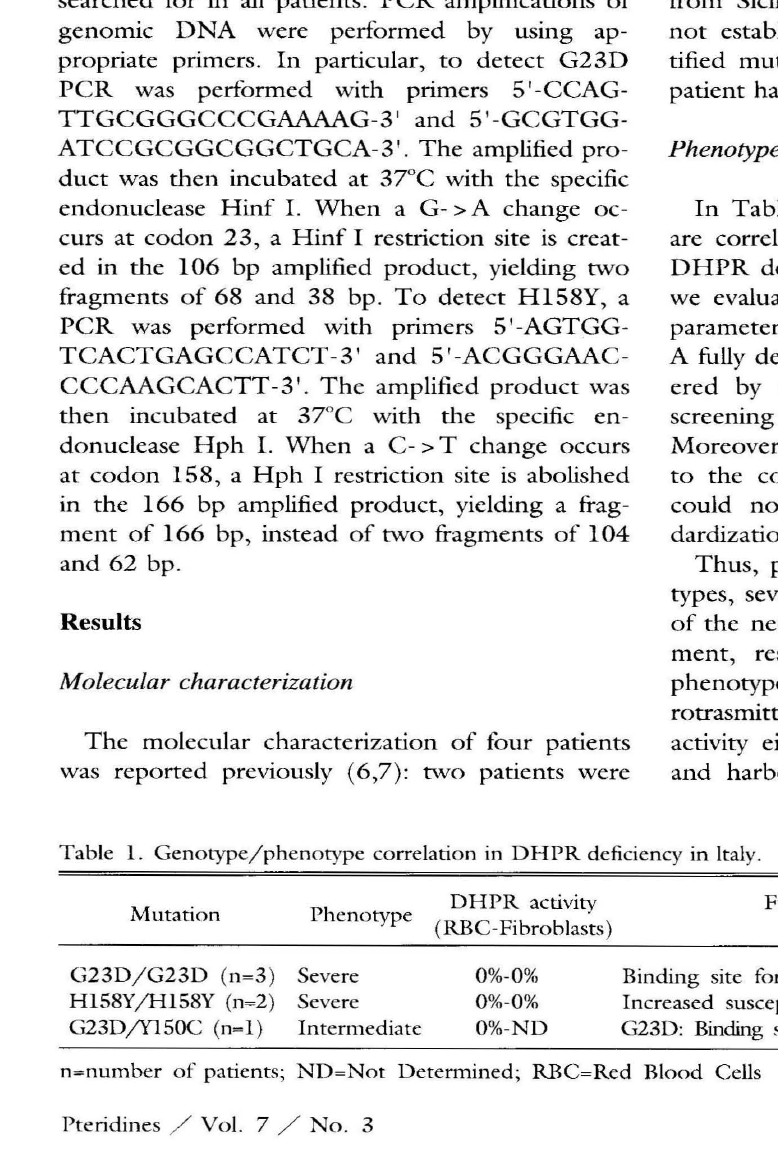
Table 1. Genotype/phenotype correlation in DHPR deficiency in Italy.